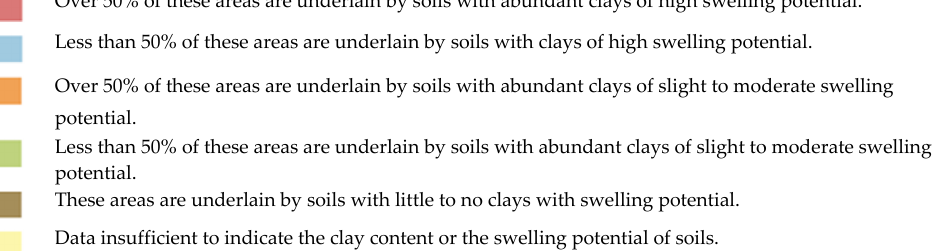
Figure 13. U.S distribution map of expansive clay [56].